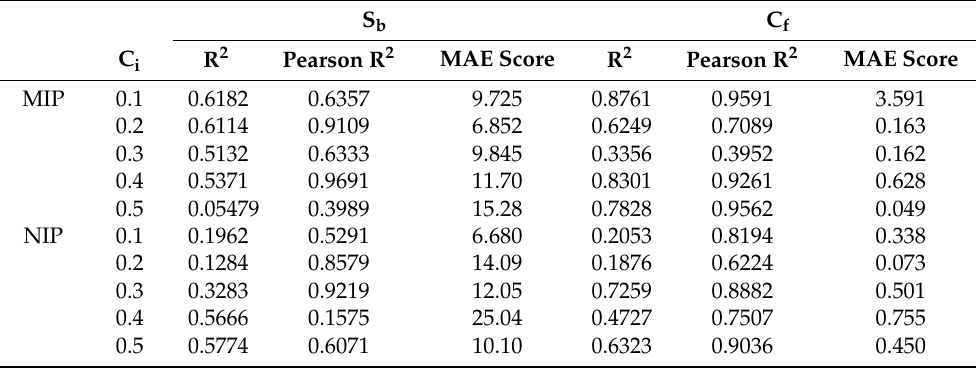
Table 8. Analysis of the error and correlation of the test datasets at a given C i value for the graph convolution model with weave